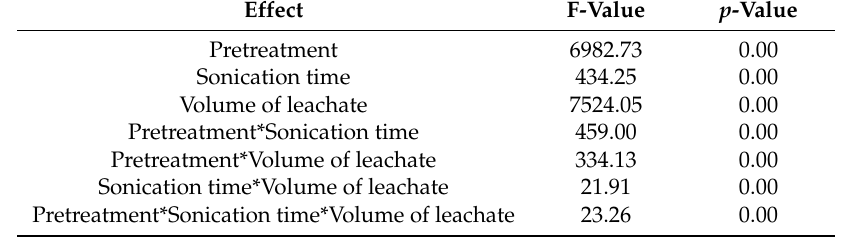
Table 6. Results of factorial ANOVA for ∆ DHA activity ∆ SOUR (*—interaction between factors).